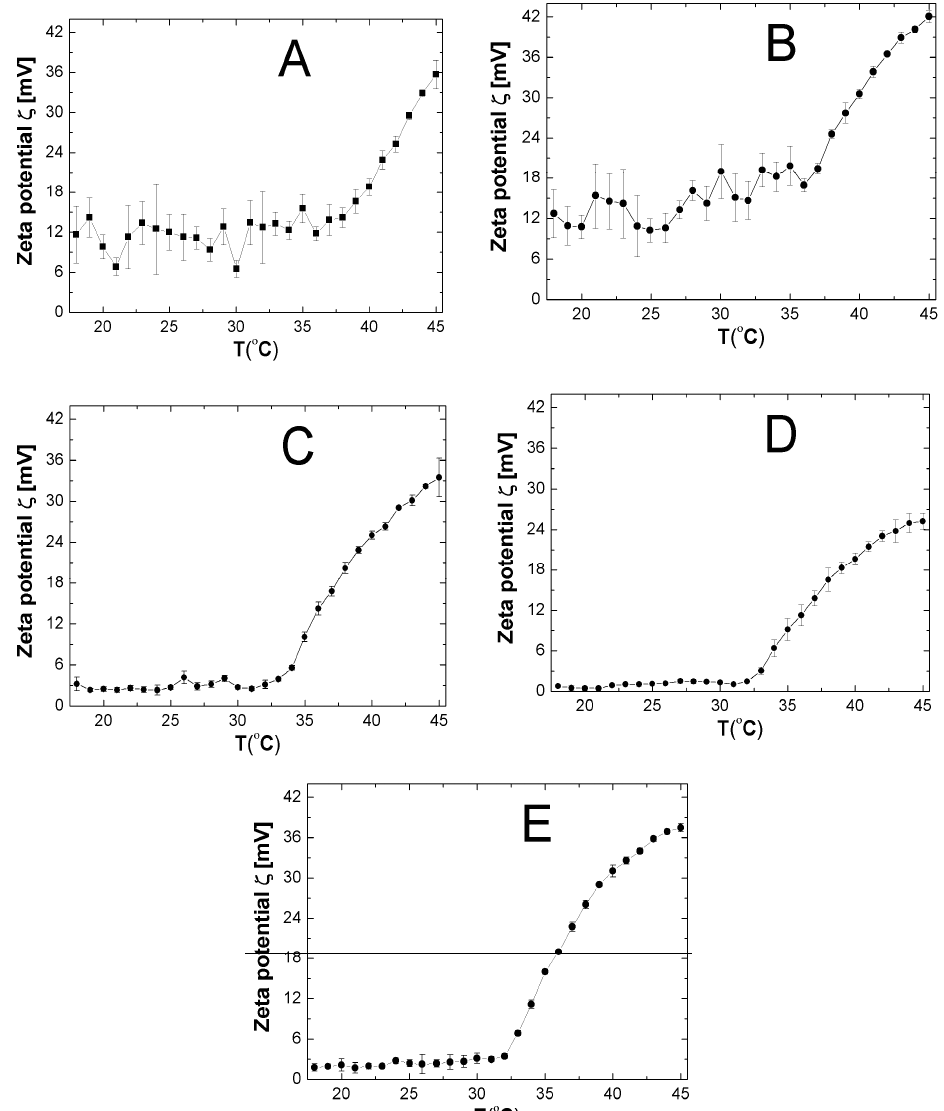
Figure 9. The effect of the temperature on the zeta potential (ZP) of the prepared nanoparticles P1 ( A ), P2 ( B ), P3 ( C ), P4 ( D ), and P5 ( E ) obtained from dynamic light scattering (DLS) measurements.